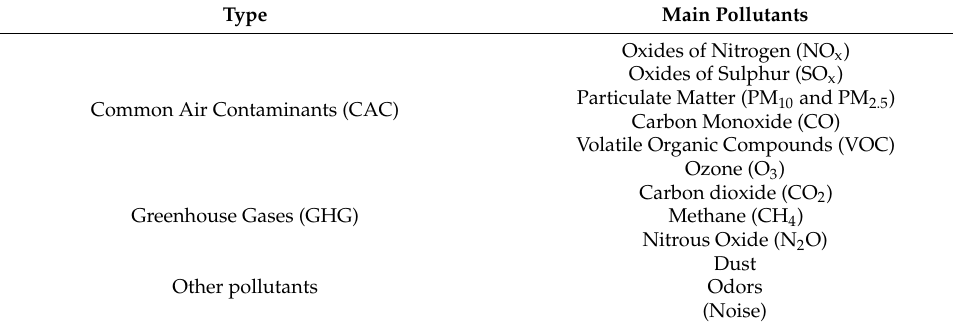
Table 1. General classification of air